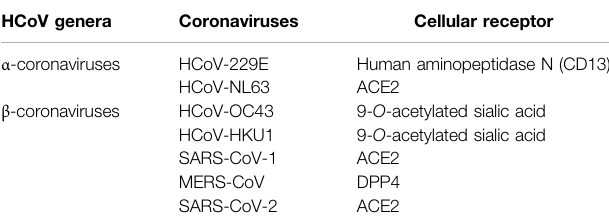
TABLE 4 | Classi fi cation and cellular receptor of the